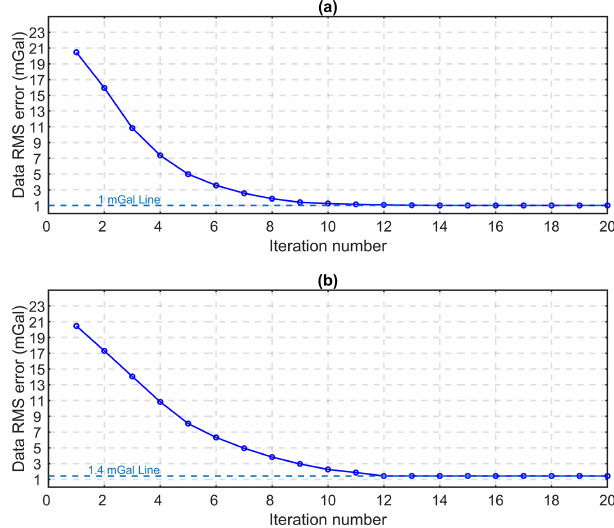
Figure 13. Evolution of data RMSE for the unconstrained (a) and constrained (b) 3D level set inversion of Yamarna